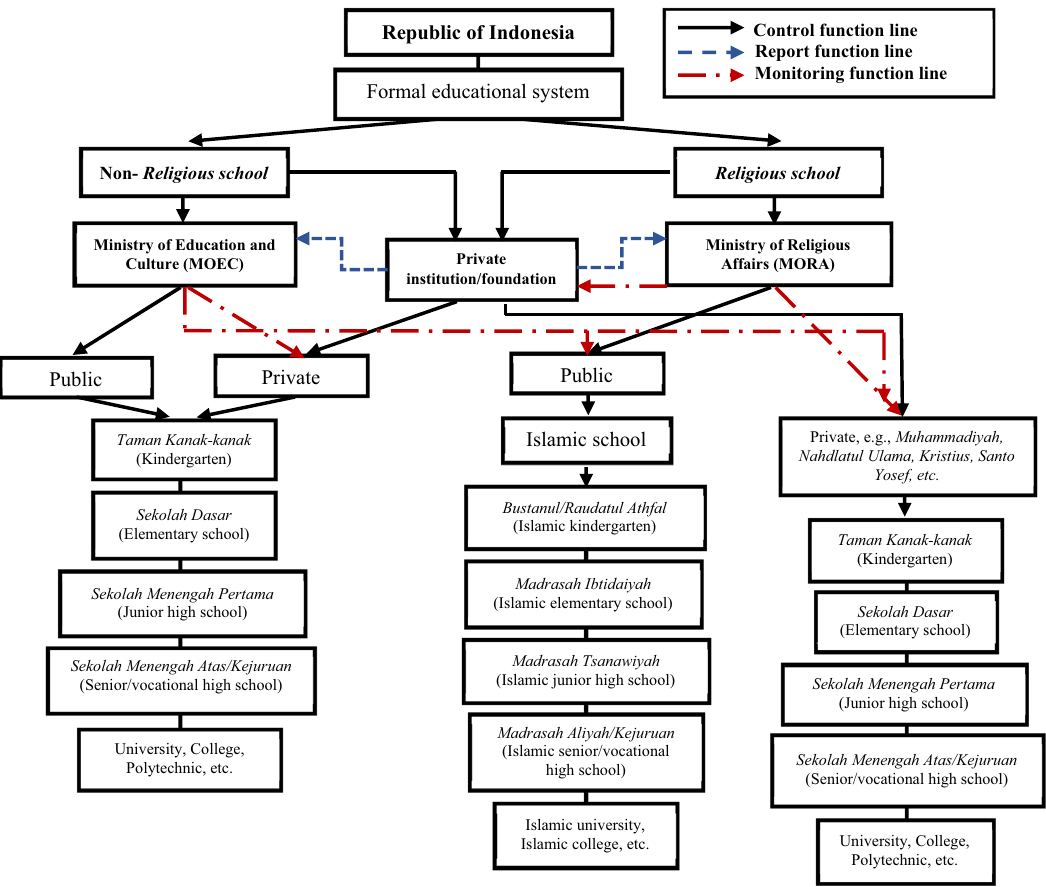
Fig. 1 Indonesia educational system. Formal educational system of Indonesia concerning religious education. Source: author attributed (developed and adapted from statistical data of education of Indonesia 2017/2018) (Ministry of Education and Culture of Indonesia, 2017; Utami et al., 2021).